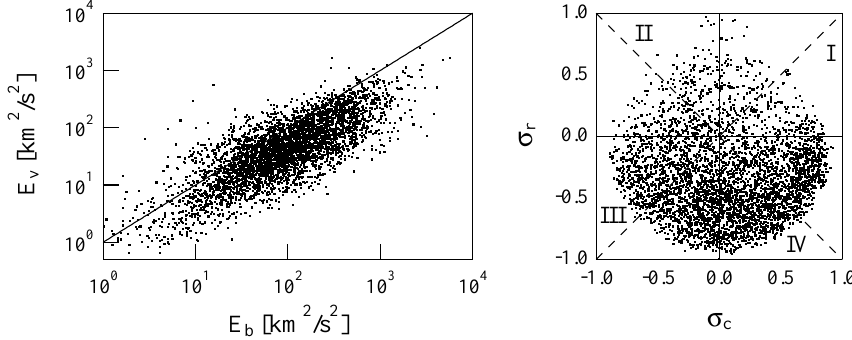
Fig. 2. The kinetic specific energy E v plotted versus the magnetic specific energy E b (left panel) and the scatter plot of the normalized residual energy σ r versus the normalized cross-helicity σ c (right panel) for the sample at 1AU. The solid line in the E v − E b plot refers to the condition of complete equipartition.